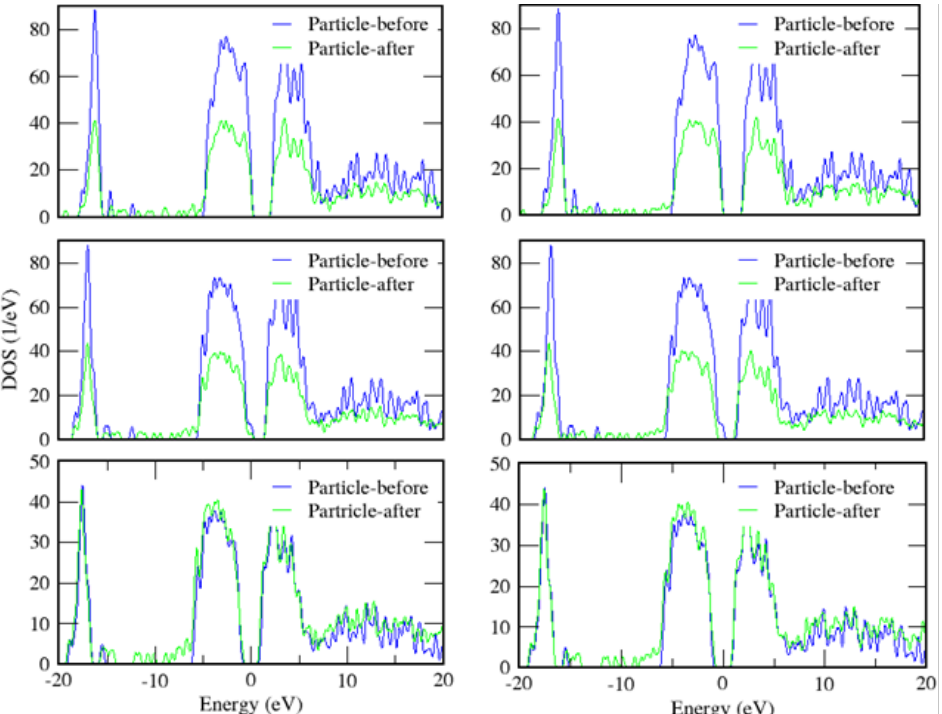
Fig. 7. DOS for the adsorption of aspirin molecule on the undoped and N-doped nanoparticle before and after the adsorption process, a: A complex, b: B complex, c: C complex, d: D complex, e: E complex and f: F